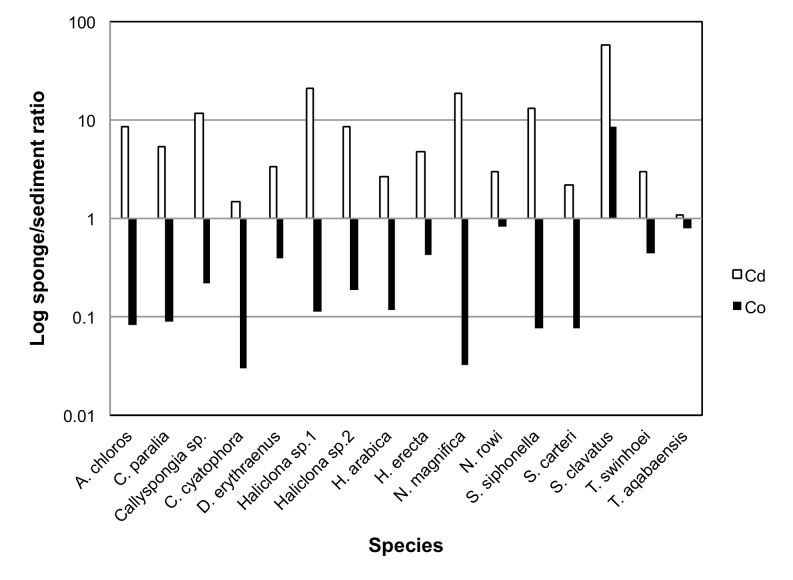
Bioconcentration factors of Cd (white) and Co (black) in all sponge species compared to sediment (value set as 1).